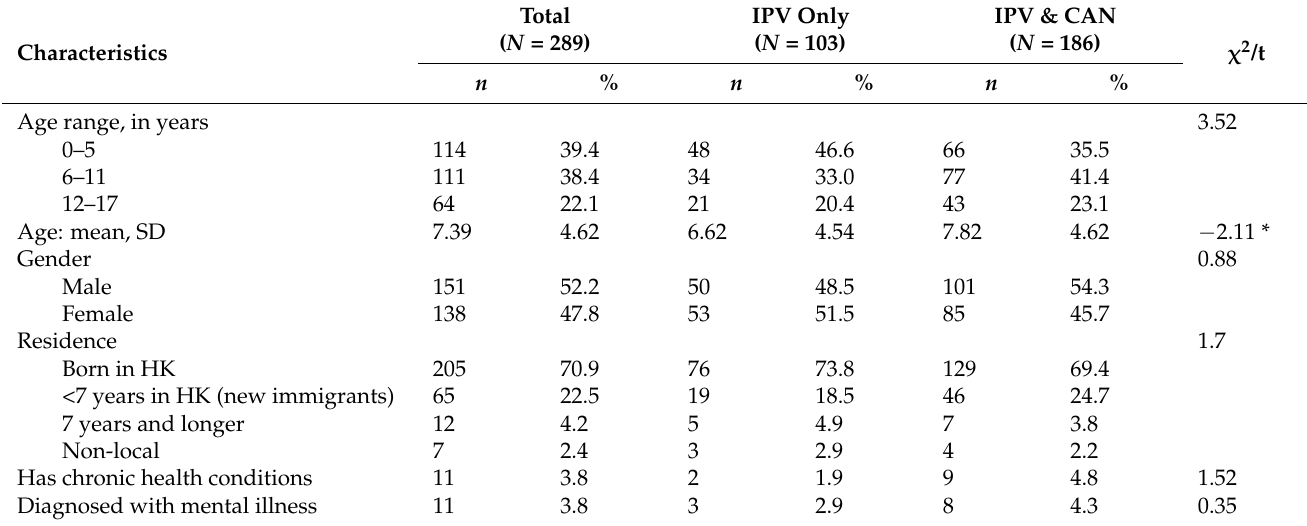
Table 2. Demographic Characteristics of the Children in the Refuge